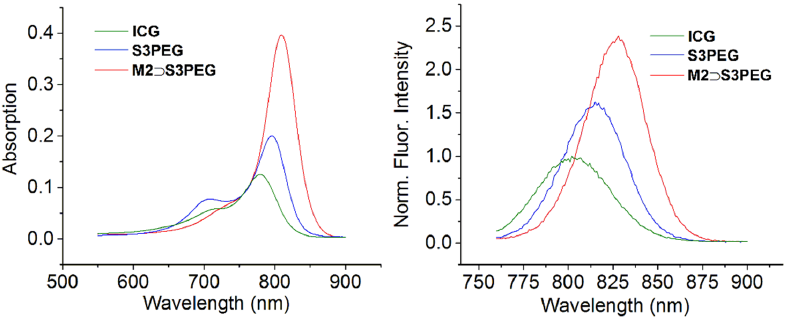
Figure 6. ( left ) Absorbance and ( right ) emission spectra (ex: 750 nm) of ICG , S3PEG , M2 ⊃ S3PEG with concentration adjusted to give identical absorbance values (0.08) at 750 nm in H 2 O.